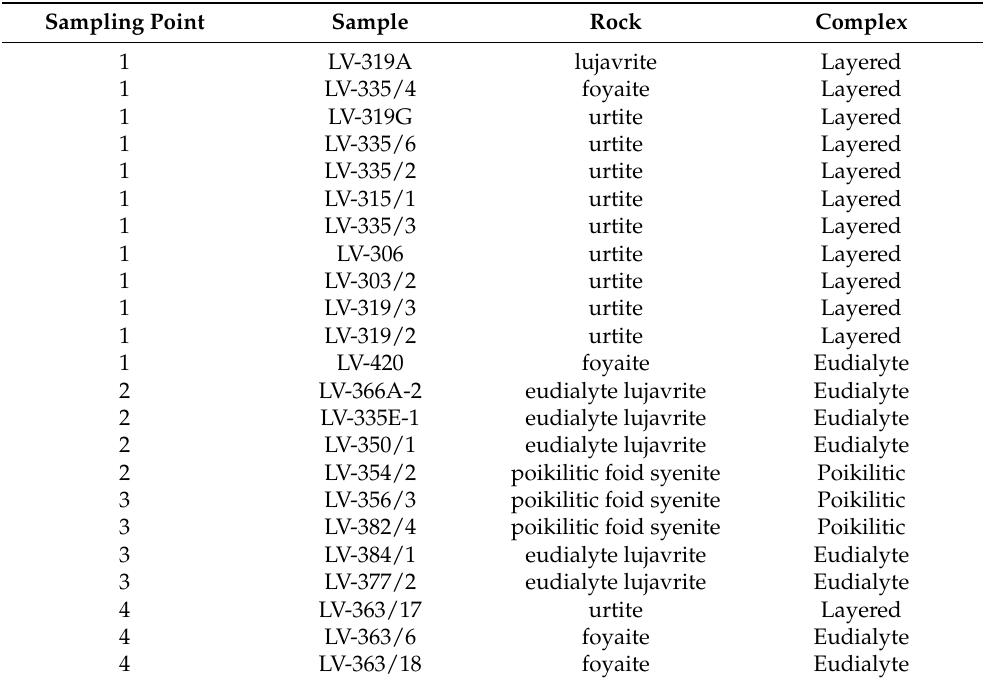
Table 2. List of studied